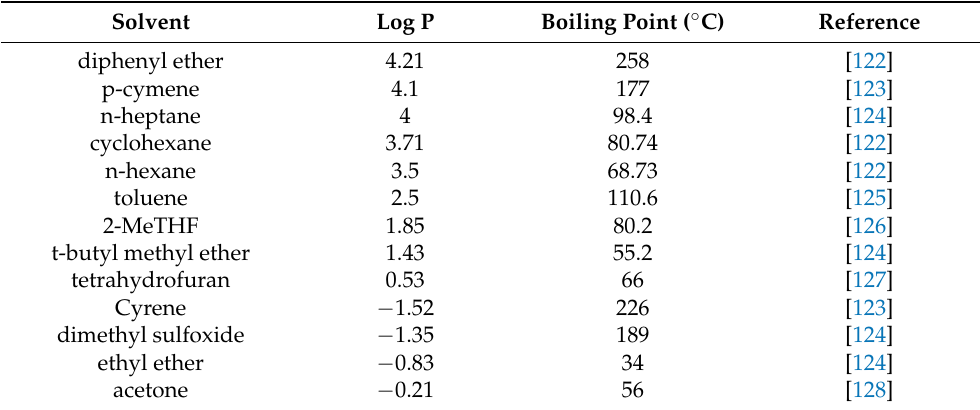
Table 1. Log P of some organic